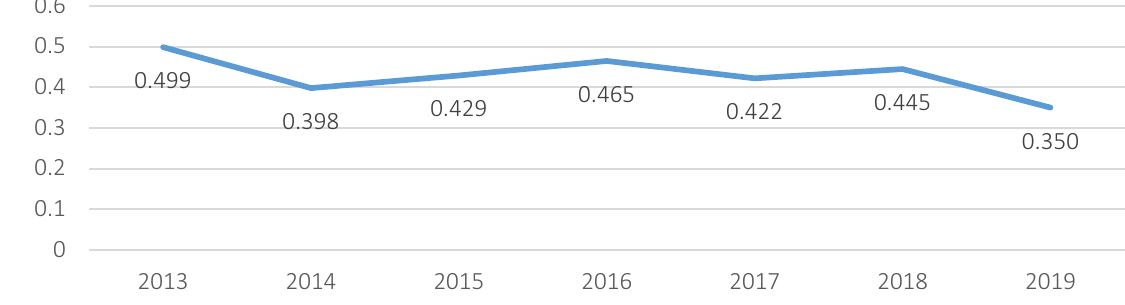
Figure 3. Dynamics of changes in the integrated index of Ukraine’s financial security for 2013–2019